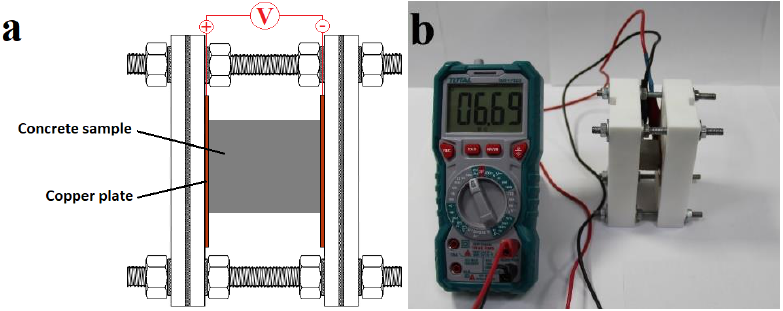
Figure 2. ( a ) The scheme of the cell setup for measurement of the electrical resistance of cement specimen and ( b ) optical image of the cell setup with connected digital multimeter. Table 1. Specifications of measurement equipment used during the